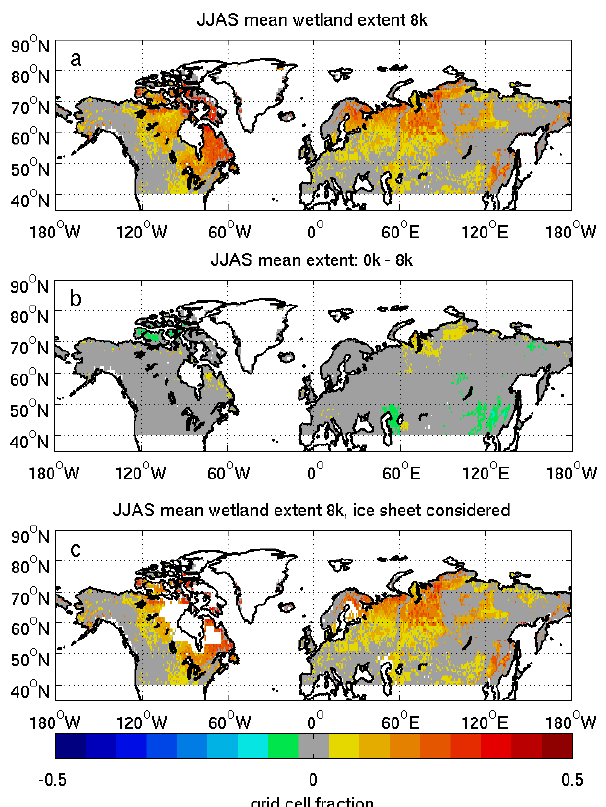
Fig. 4. Summer (JJAS) mean wetland extent at 8ka BP. Upper panel (a) : extent as grid cell fraction. Middle panel (b) : Difference to extent at 0ka. Lower panel (c) : As (a), but areas covered by ice sheet or below sea level masked